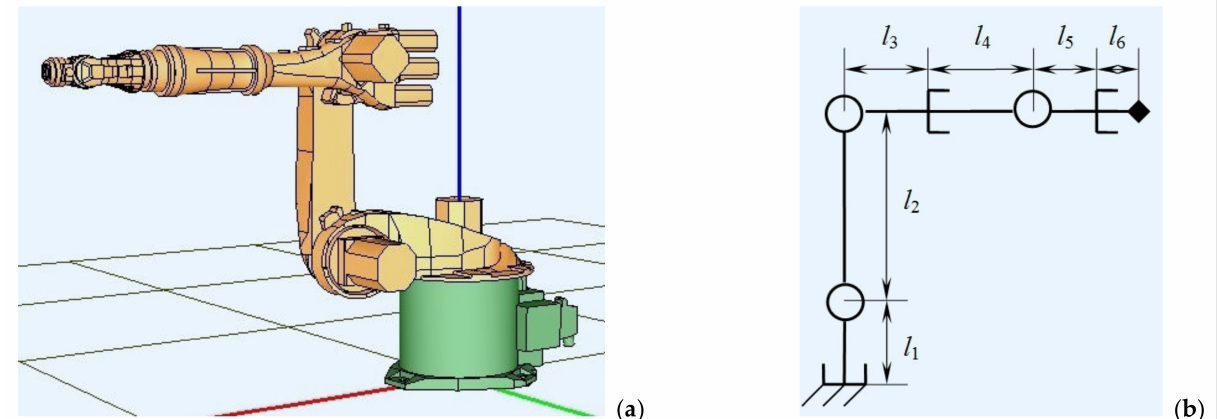
Figure 1. 6-DOF robot manipulation system ( a ) and its kinematic scheme ( b ).